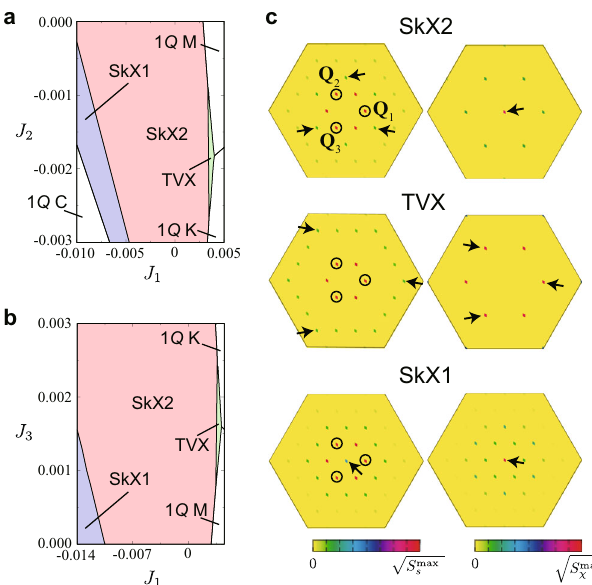
Fig. 2 Variational ground states of the Kondo lattice model with the exchange interactions between the localized spins up to third neighbors, J J J 1 , 2 , and 3 . Variational phase diagrams on the planes. c Spin (left) and chirality (right) structure factors for the SkX2 (top), TVX (middle), and SkX1 (bottom). The circles represent the peak positions at Q 1 , Q 2 , and Q 3 , and the arrows indicate the subdominant (dominant) peak positions in the spin